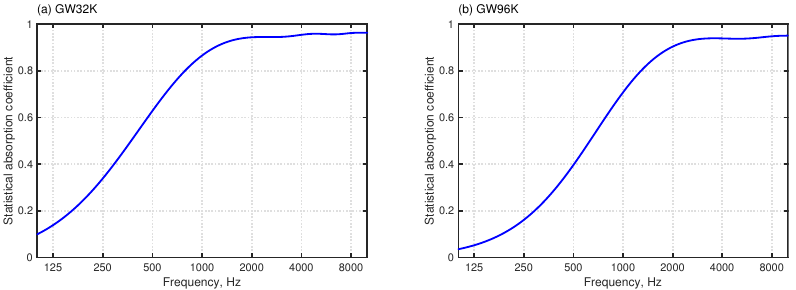
Figure 2. Statistical absorption coefficient for ( a ) GW32K and ( b )